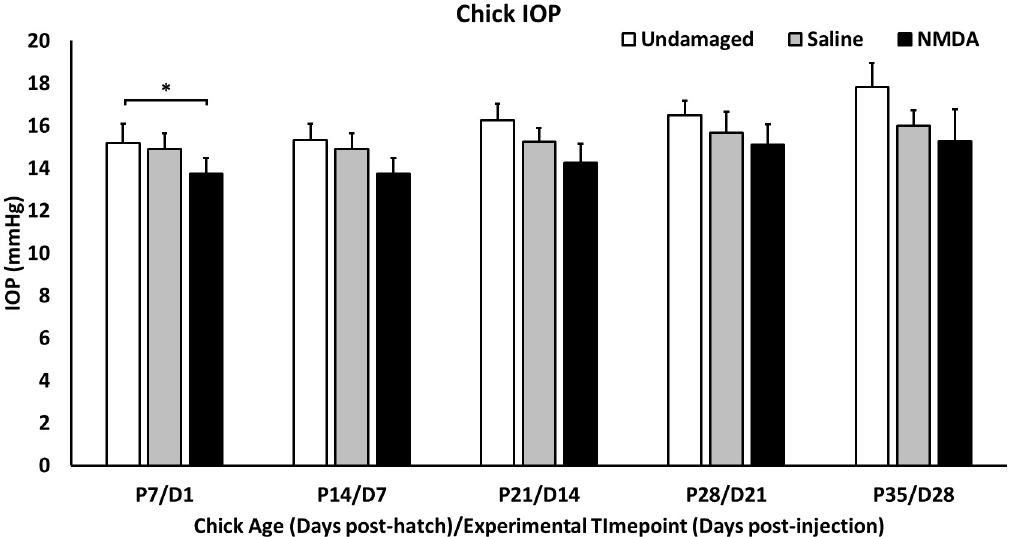
Fig 2. IOP measurements. Chick IOP measurements on undamaged chicks and NMDA-damaged chicks (OD: Saline, OS: NMDA) taken weekly starting at post-hatch day 7 or post-injection day 1 till post-hatch day 35 or post-injection day 28.